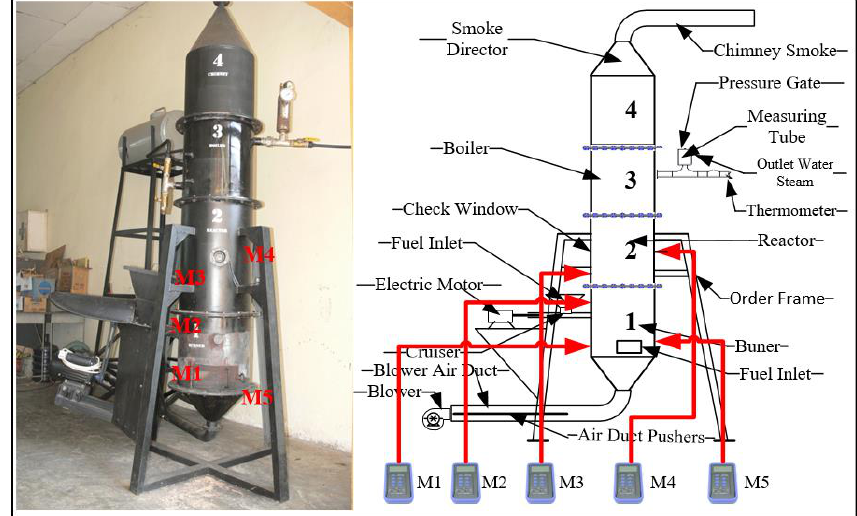
Figure 2. Experimental Setup.